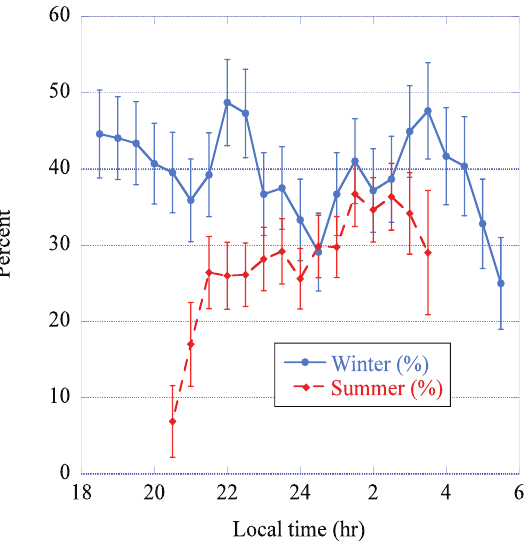
Fig. 5. Local time dependence of ripple occurrence frequency in Colorado. Error bar is denoted by the thin line. The summer here includes May, June, July and August; and winter includes Novem- ber, December, January and